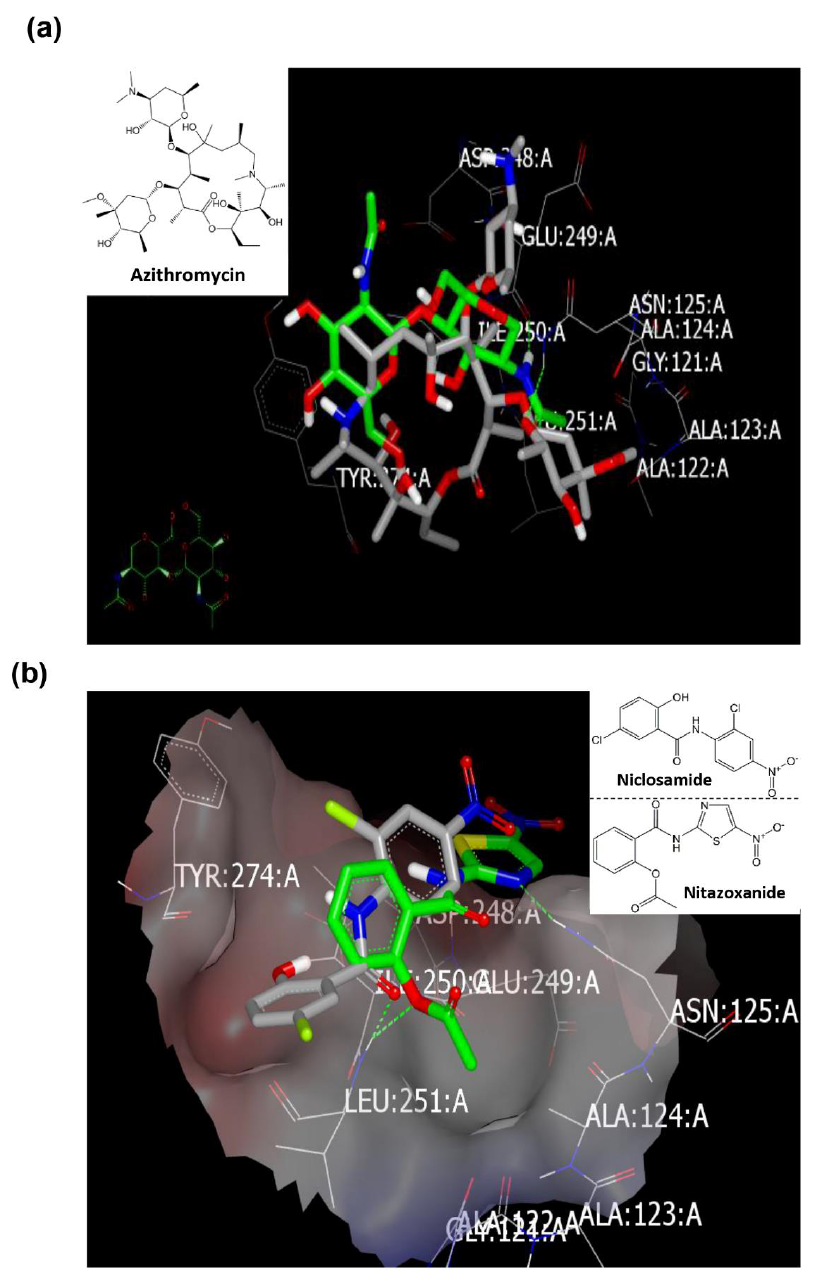
Figure 6. Visual representation by VIDA for docking with the main protease of MERS-CoV (PDB ID: 4ylu). ( a ) Niclosamide (green color) and Nitazoxanide (grey color) overlay each other, ( b ) ligand (grey color), Niclosamide (green color), and Nitazoxanide (grey color with yellow sulfur atom color) inside the inner grid for validation, and ( c ) Azithromycin with amino outside the grid.